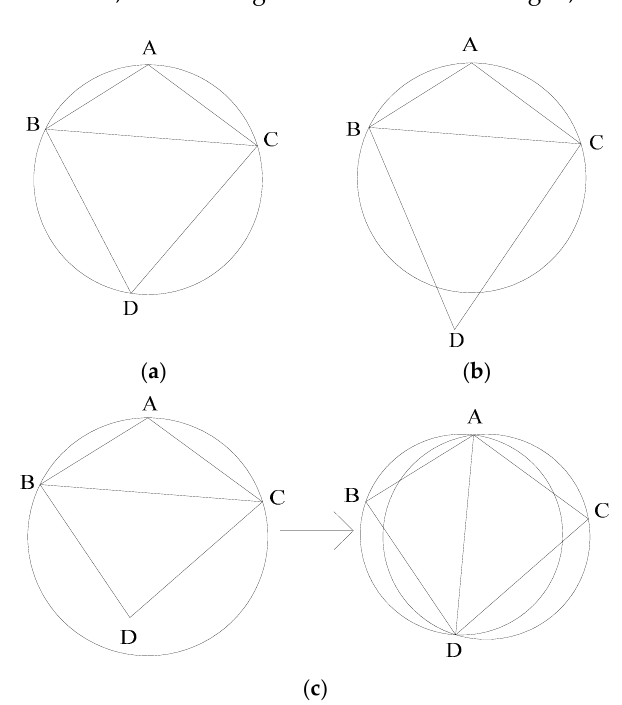
Figure 3. The relationship between point D and circumcircle of triangle ABC. ( a ) Point D is on the circumcircle; ( b ) Point D is outside the circumcircle; ( c ) Point D is inside the circumcircle.